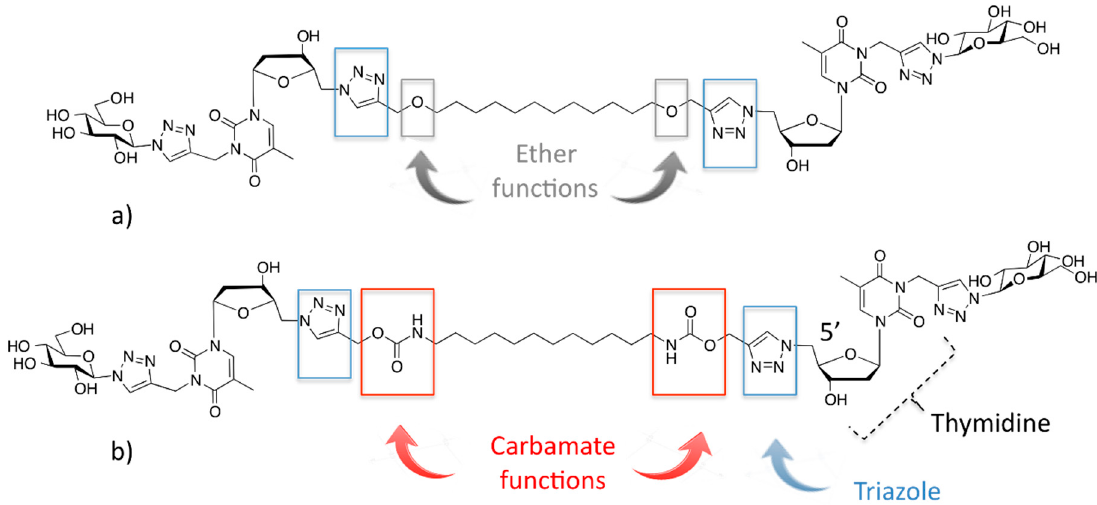
Figure 1. Schematic representations of bolaamphiphile structures. ( a ) Bolaamphiphile structure previously reported (see [15]). The hydrophobic segment is attached via ether functions. ( b ) Bolaamphiphile structures with carbamate functions described in this study.